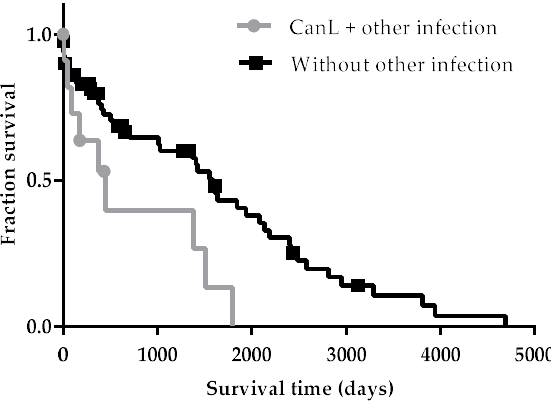
Figure 5. Influence of coinfections at the time of diagnosis on the survival time of patients with CanL. Log-rank (Mantel–Cox) test was used to compare the survival time of patients with CanL and patients with CanL and others infectious diseases. Both events (death) and censored data were considered. Dots and squares represent censored dogs.